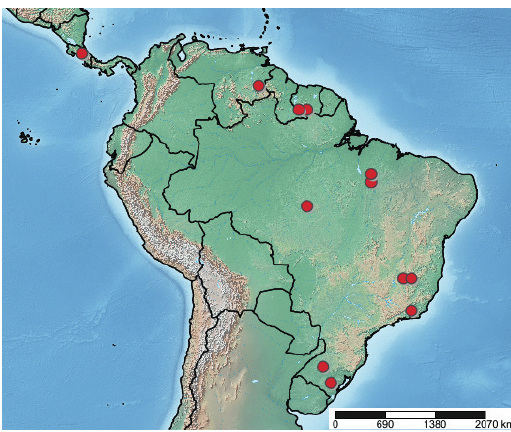
Figure 2. Map of sampling locations, appearing as red dots, across Central and South America (Sim- pleMappr). Some samples of different species were collected in the same river at the same approximate coordinates and appear as the same